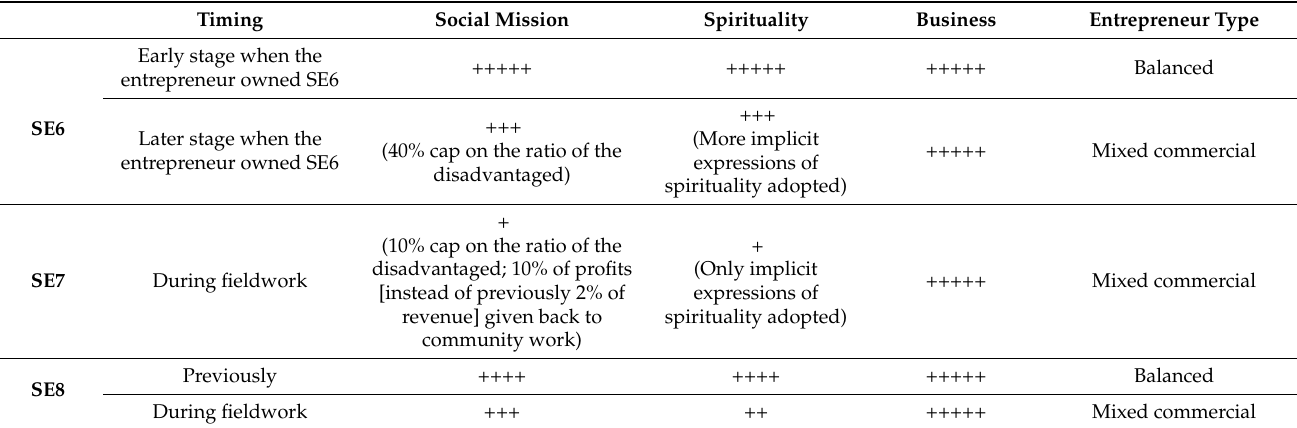
Table 4. Emphasis on institutional logics (mixed commercial